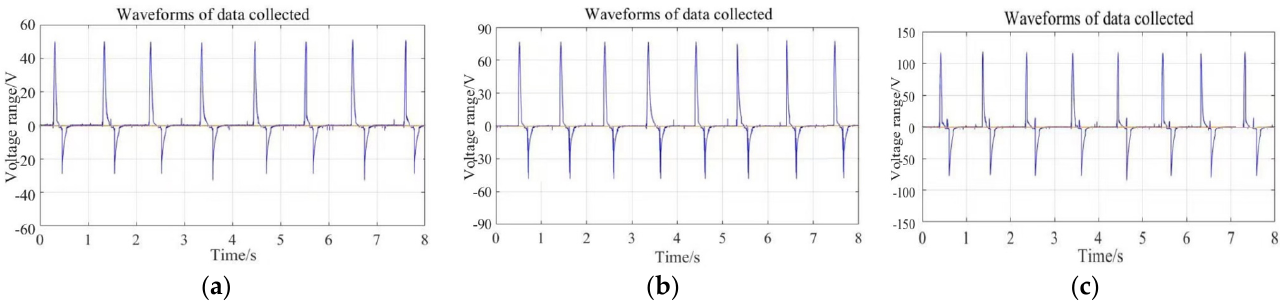
Figure 7. Reported voltages from 1#1 PZT4 patch on unimorph PCS of 1# piezoelectric brick ( F = 500 N, f = 1 Hz). ( a ) L = 19.5 mm; ( b ) L = 26.5 mm; ( c ) L = 33.5 mm.